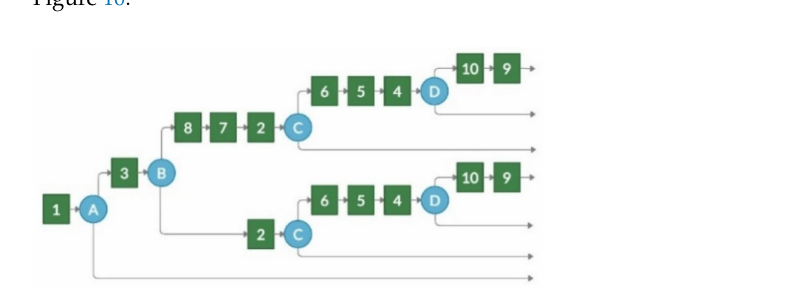
Figure A2. Result of original contextual graph transformation to Practice tree for graph, presented in Figure 10.